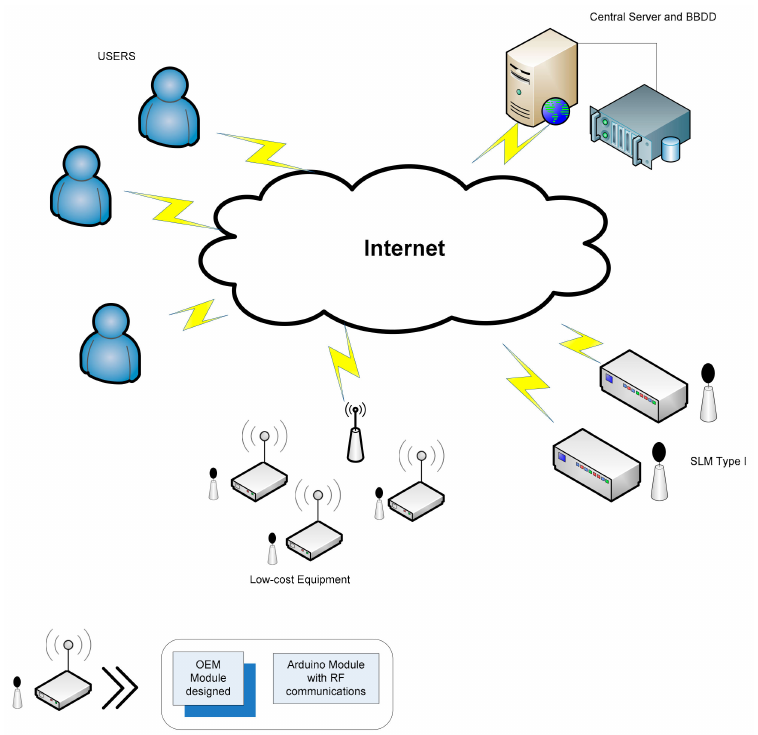
Figure 11. Network architecture and details of the low-cost monitors.